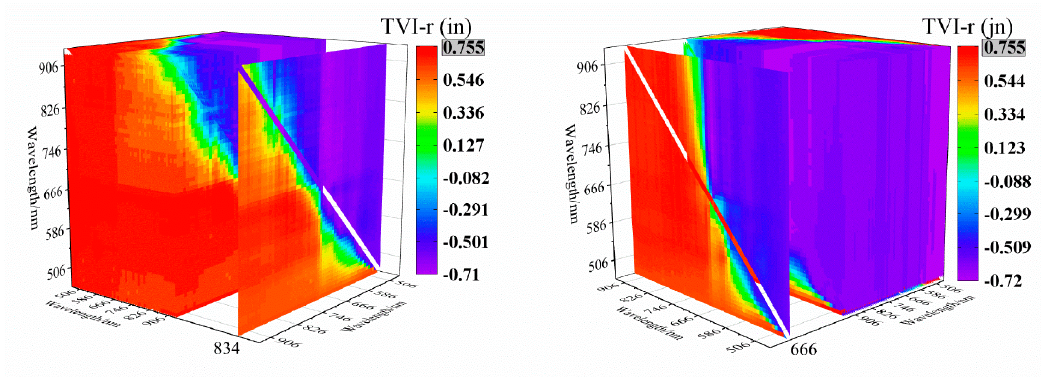
Figure 15. Three-dimensional r diagram of SMC and triangle vegetation index (TVI).